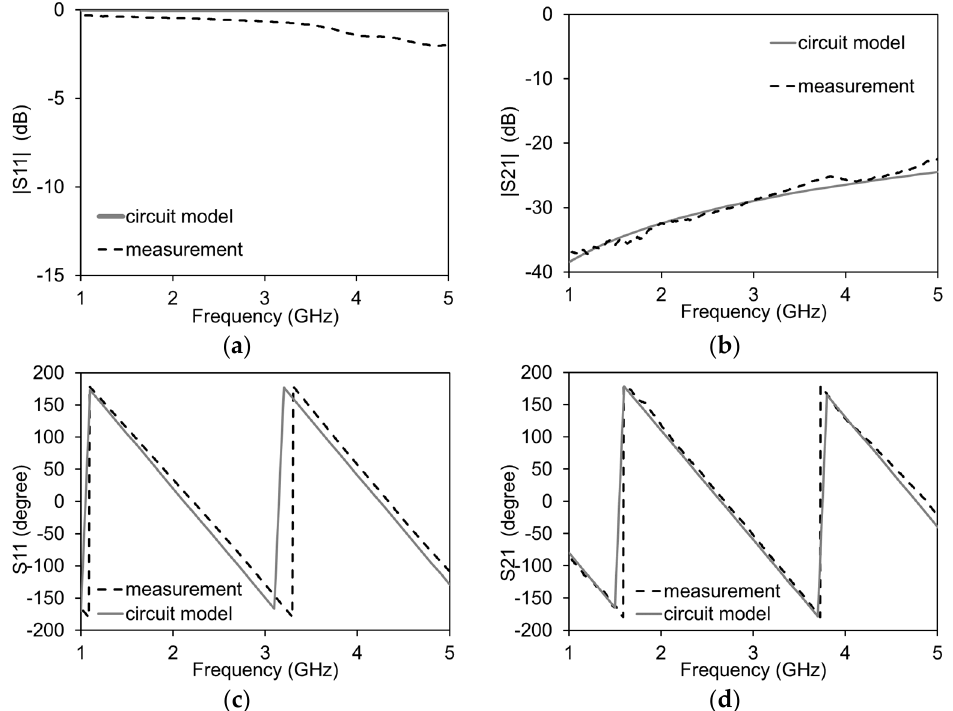
Figure 12. Simulated (solid lines) and measured (dashed lines) scattering parameters of gap: ( a ) amplitude of reflection coefficient (dB); ( b ) amplitude of transmission coefficient (dB); ( c ) phase of the reflection coefficient (deg); ( d ) phase of the transmission coefficient (deg).